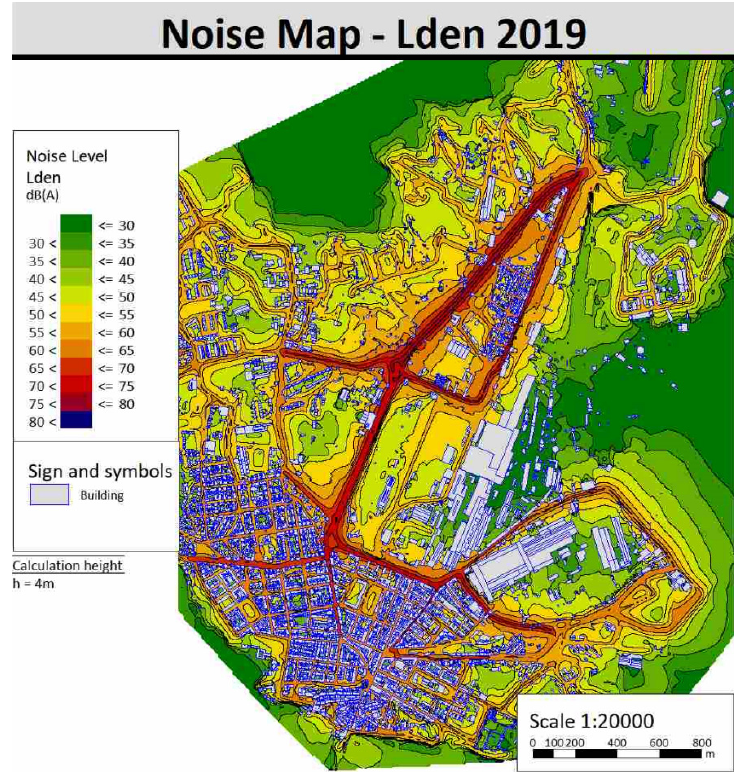
Figure 13. Noise maps of Piombino with L den indicator for 2019.